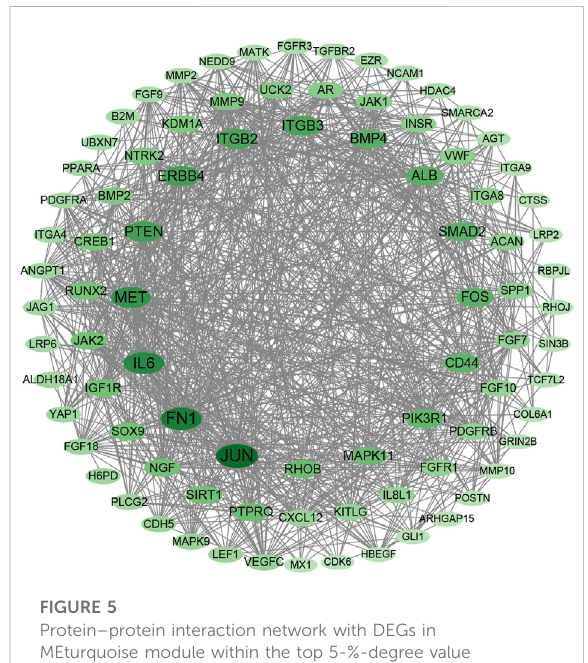
FIGURE 5 Protein – protein interaction network with DEGs in MEturquoise module within the top 5-%-degree value (Supplementary Table